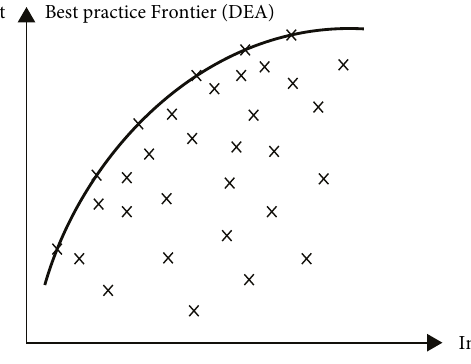
Fig. 1. Efficient frontier of